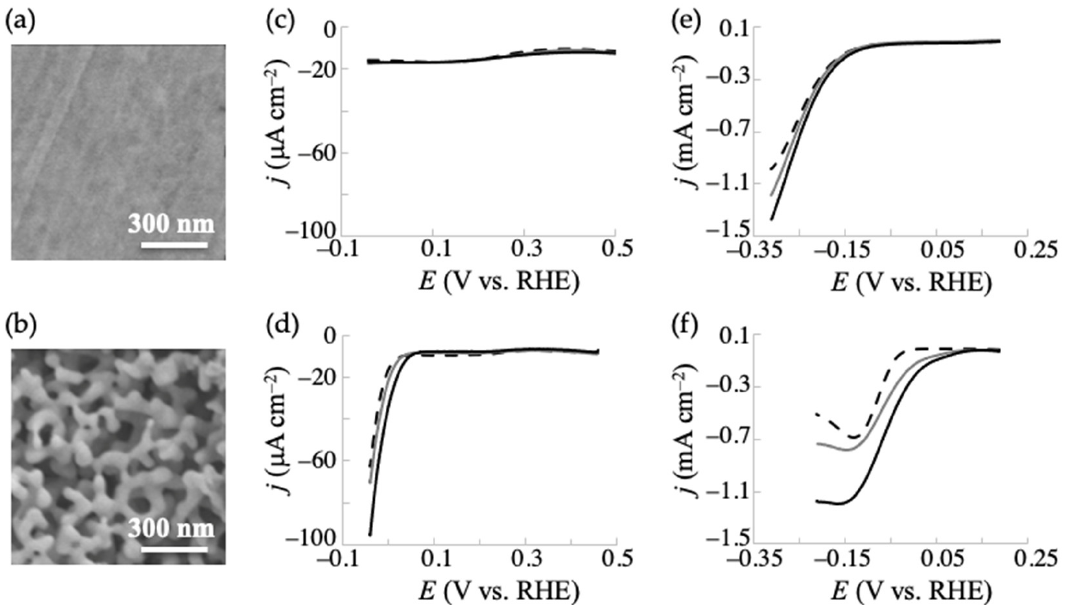
Figure 2. Surface morphologies of ( a ) planar (nonanodized) gold and ( b ) anodized NPG electrodes observed by SEM. ( c – f ) Cyclic voltammograms obtained at the electrodes. Voltammograms for 25 mM (gray line) and 50 mM (black line) of α -ketoglutaric acid measured in ( c , d ) 1.5 M of NH 3 /NH 4 Cl solution (pH 10) and ( e , f ) 0.15 M of NaCl solution containing 50 mM of NH 2 OH (pH 1.6) at ( c , e ) planar-gold and ( d , f ) NPG electrodes. Dashed lines indicate voltammograms recorded without α -ketoglutaric acid and NH 2